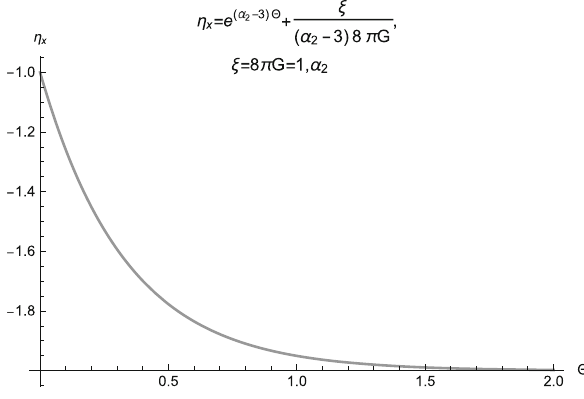
Fig. 5 The variation of η x with respect to (cid:16) for F 2 where vacuum energy density, (cid:5) (cid:2) = matter density, (cid:5) m = y